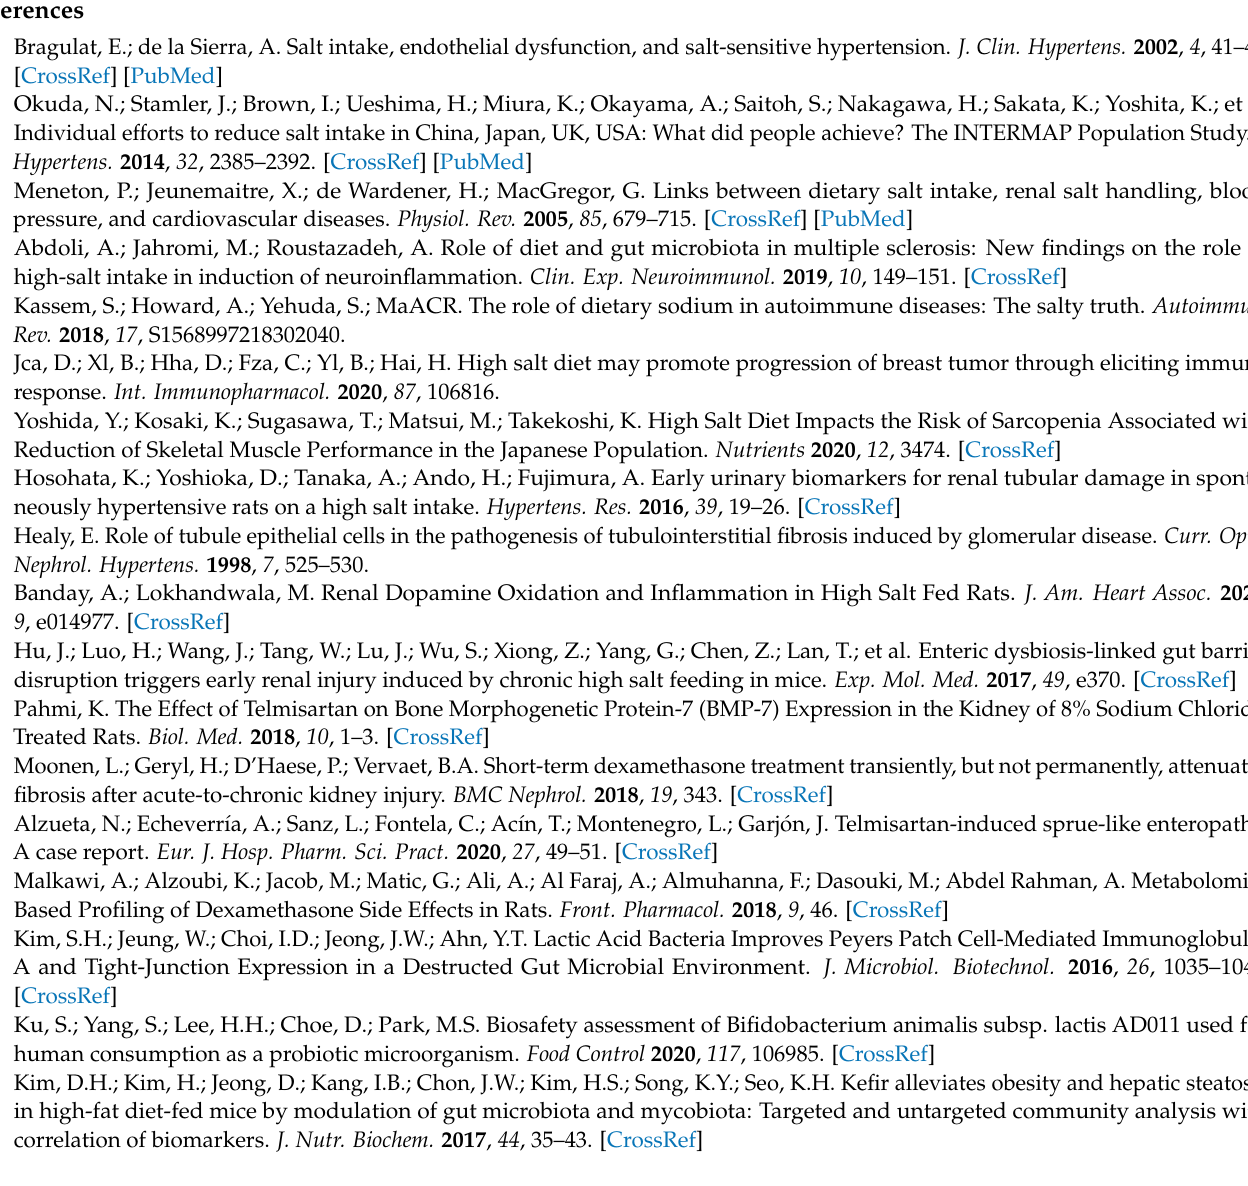
Figure S7: Spearman correlation coefficient matrix heat map between intestinal flora and serum metabolites. Figure S8: The scatter plot reflects the correlation between a single significantly different metabolite and a significantly different genus. Table S1: Primer sequence information table for mouse cytokines and tight junction